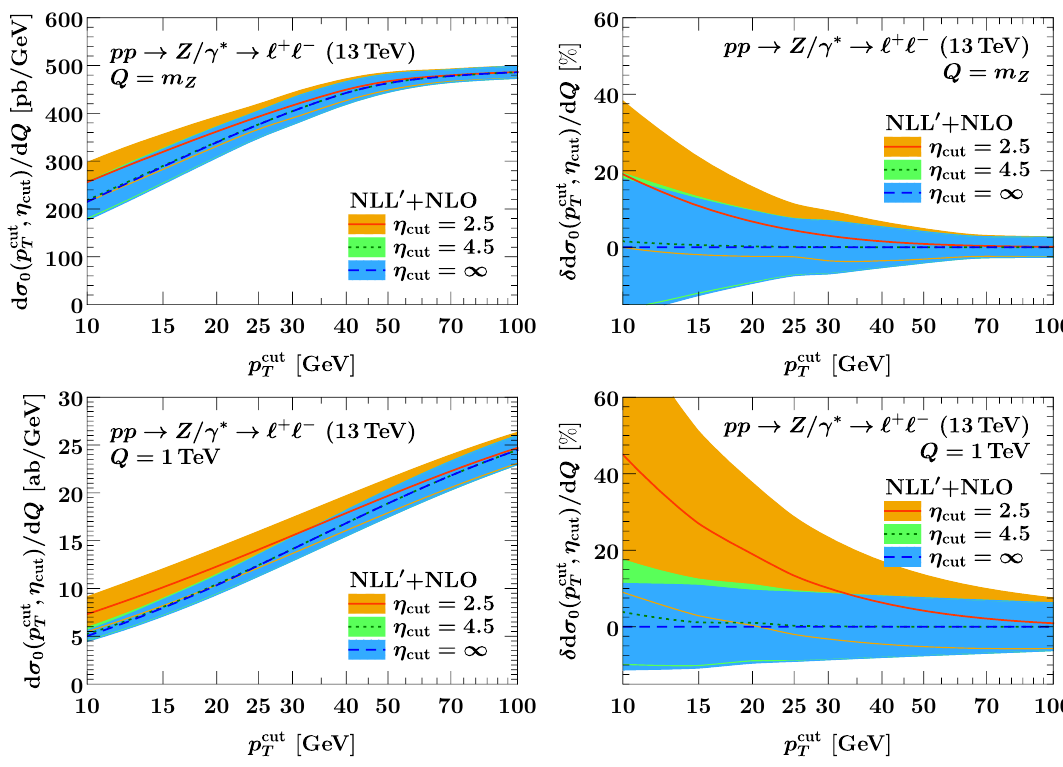
Figure 14 . The 0-jet cross section d (cid:27) 0 ( p cut ; (cid:17) cut ) = d Q for Drell-Yan production at the Z pole T Q = m Z (top row) and at Q = 1 TeV (bottom row) at NLL 0 +NLO for di(cid:11)erent values of (cid:17) cut . The bands indicate the total uncertainty (cid:1) (cid:22) 0 (cid:1) res . The absolute cross section is shown on the left. (cid:8) On the right, the same results are shown as the percent di(cid:11)erence relative to the 0-jet cross section at (cid:17) cut = . 1